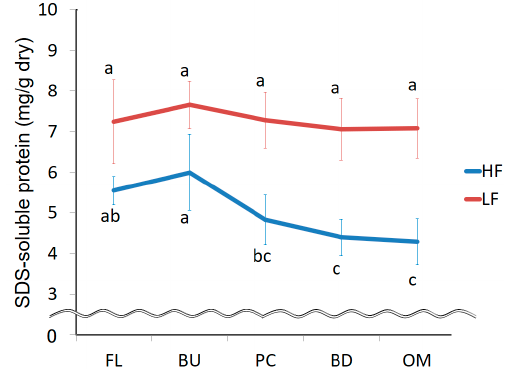
Figure 6. Changes in protein Z aggregates extracted with 0.5% SDS during mixing. FL, BU, PC, BD, and OM indicate flour (before mixing), build up, peak consistency, breakdown, and overmixing, respectively. HF and LF mean high protein flour and low protein flour. The error bars show standard deviations ( n = 6). Different letters on the graph indicate significant differences ( p < 0.05).